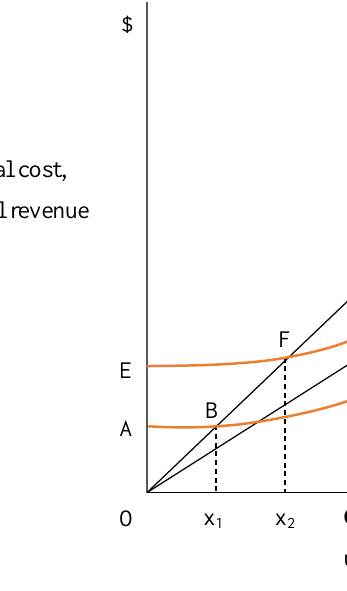
Figure 2. A microeconomic illustration that higher levels of inescapable costs increase the vulnerabil- ity of businesses to pandemics (such as COVID-19) if the demand for their product declines or if they are forced to reduce the supply of their product.